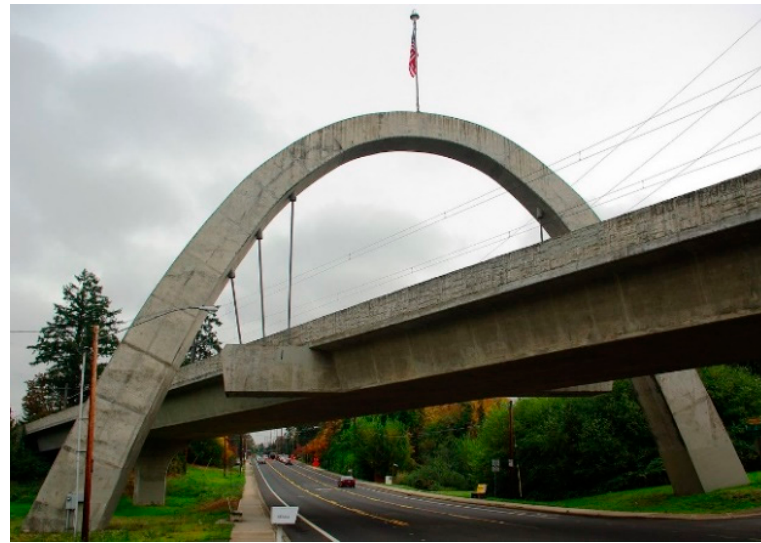
Figure 10. Hillsboro Main Street Bridge (photo: M.O. Stevens, Wikimedia Commons).